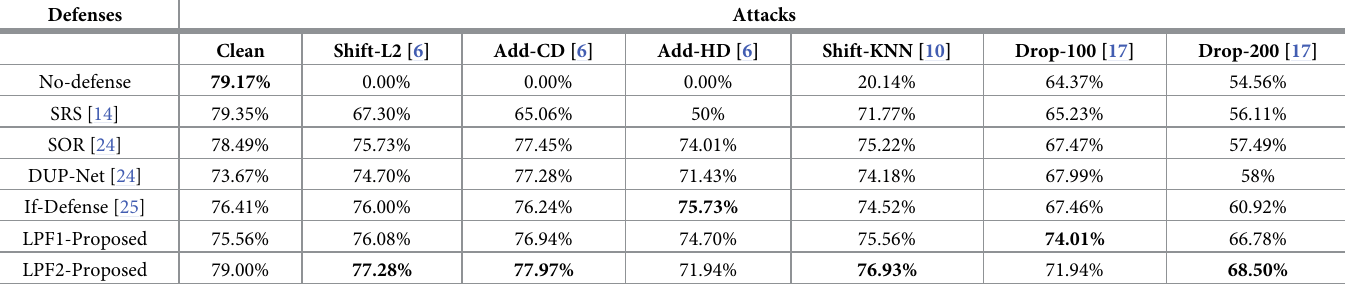
Table 4. Comparison of classification accuracy of proposed defenses with other defense strategies, under various attacks on PointNet and ScanObjectNN datasets.